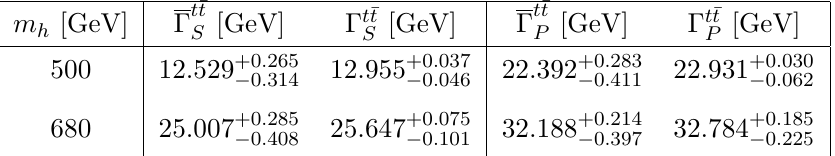
(cid:22) t and (cid:0) t (cid:22) t ( X = S; P ), of a scalar and pseudoscalar X X